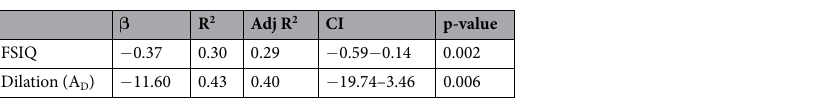
Table 2. Stepwise Linear Regression Analysis to predict SRS Total T-scores. β = Beta weight; R 2 = explained variance; Adj R 2 = adjusted variance; CI = 95% confidence internal.